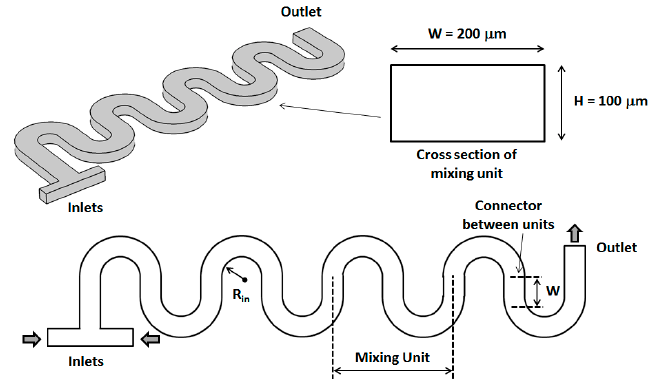
Figure 1. 3D and top views of the standard serpentine micromixer with a rectangular cross-section defined by W = 200 μ m and H = 100 μ m.